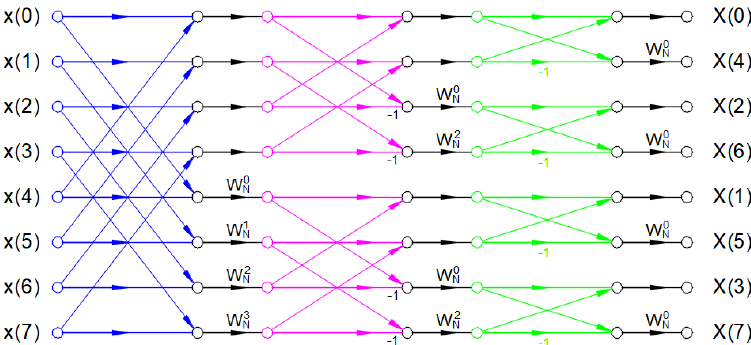
Figure 5. Eight-point radix-2 decimation-in-frequency FFT [15].